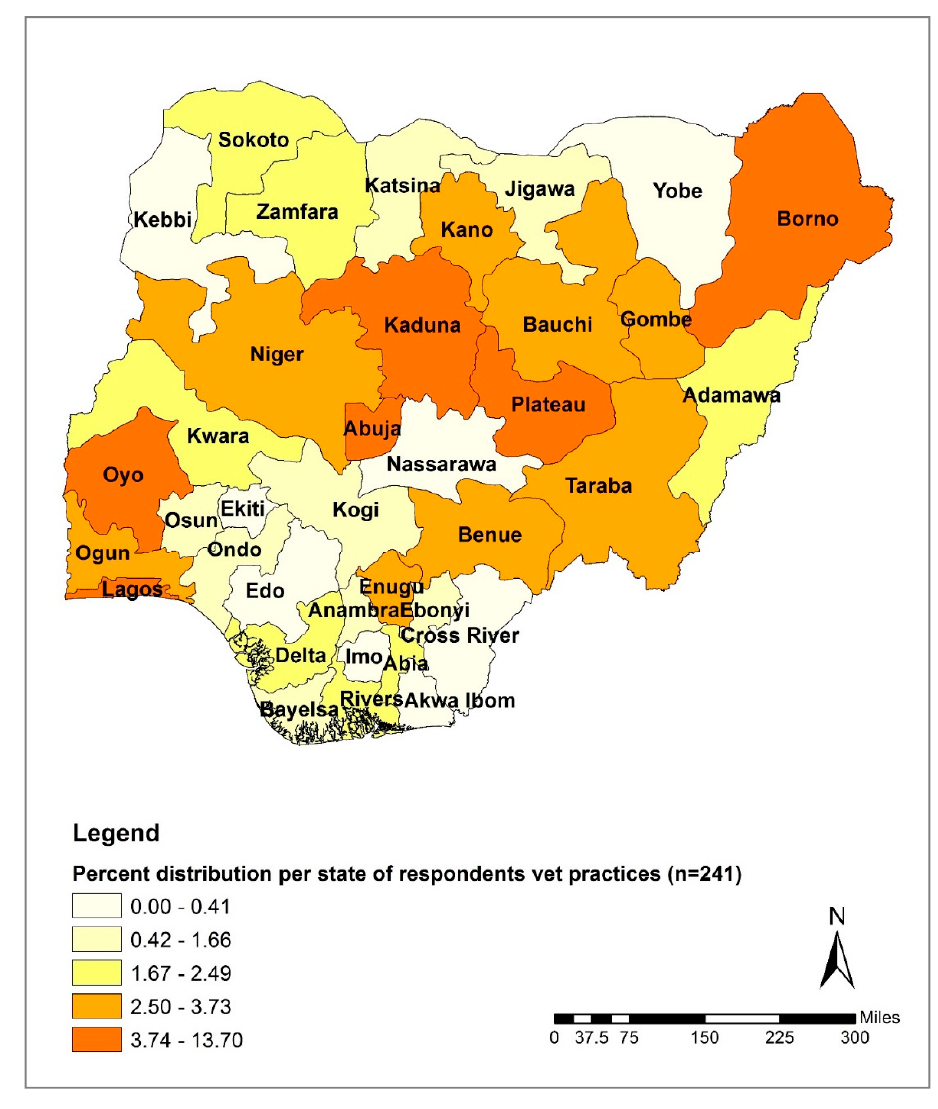
Figure 1. Distribution of survey respondents based on reported location of veterinary practice by state in Nigeria.